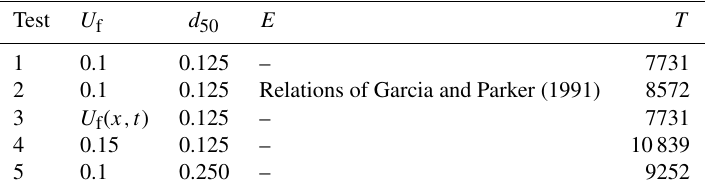
Table 1. Initial boundary conditions for the 5 Test